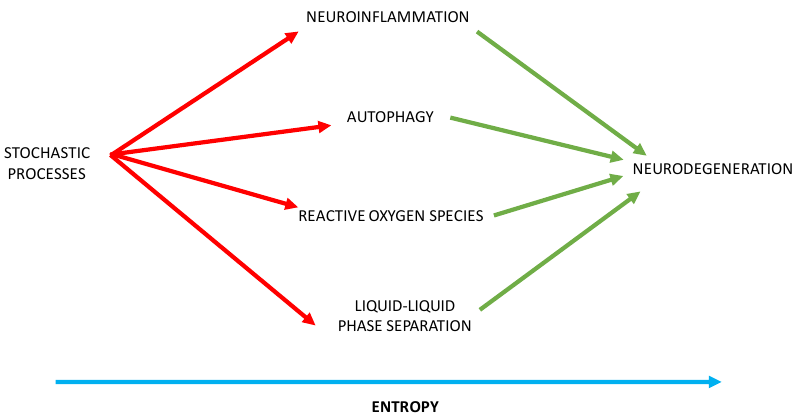
Figure 6. Stochastic processes and the mechanisms of neurodegeneration.